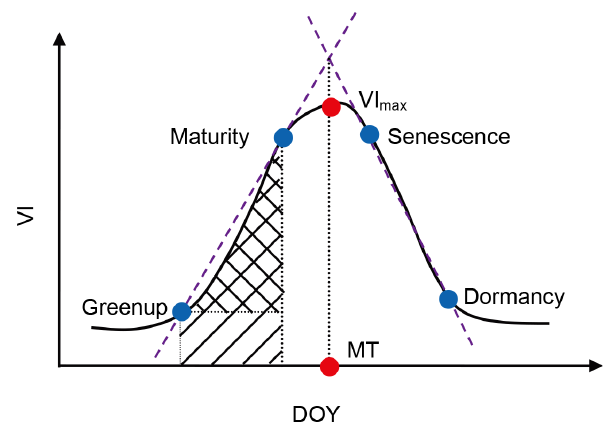
Figure 3. Diagram of parameter extraction from time series vegetation index (VI) data. Blue points represent time points separating different vegetation growth stages, while red points are parts of the extracted